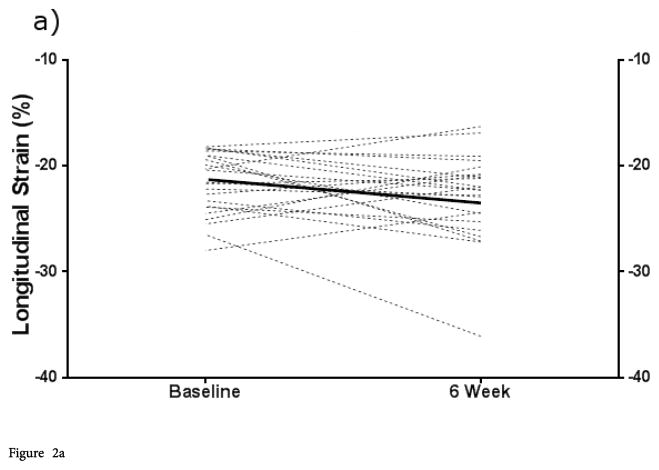
Figure 2a: Change in ε (longitudinal and circumferential) from acute to convalescent phase stratified by baseline longitudinal or circumferential ε. Baseline longitudinal ε ≤ −18 (normal or hyperdynamic).Figure 2b: Change in ε (longitudinal and circumferential) from acute to convalescent phase stratified by baseline longitudinal or circumferential ε. Baseline longitudinal ε≥18 (low).Figure 2c: Change in ε (longitudinal and circumferential) from acute to convalescent phase stratified by baseline longitudinal or circumferential ε. Baseline circumferential strain lower 25%.Figure 2d: Change in ε (longitudinal and circumferential) from acute to convalescent phase stratified by baseline longitudinal or circumferential ε. Baseline circumferential strain upper 75%. Bold lines represent mean values.